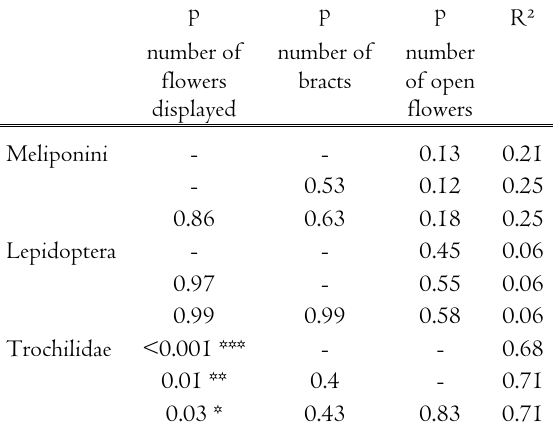
inflorescence attractiveness on the number of visits. Each visitor group was tested separately (R² = coefficient of determination, p